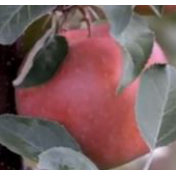
Figure 6. Apple identified in second the frame, noted as detection 1 is tested for association.